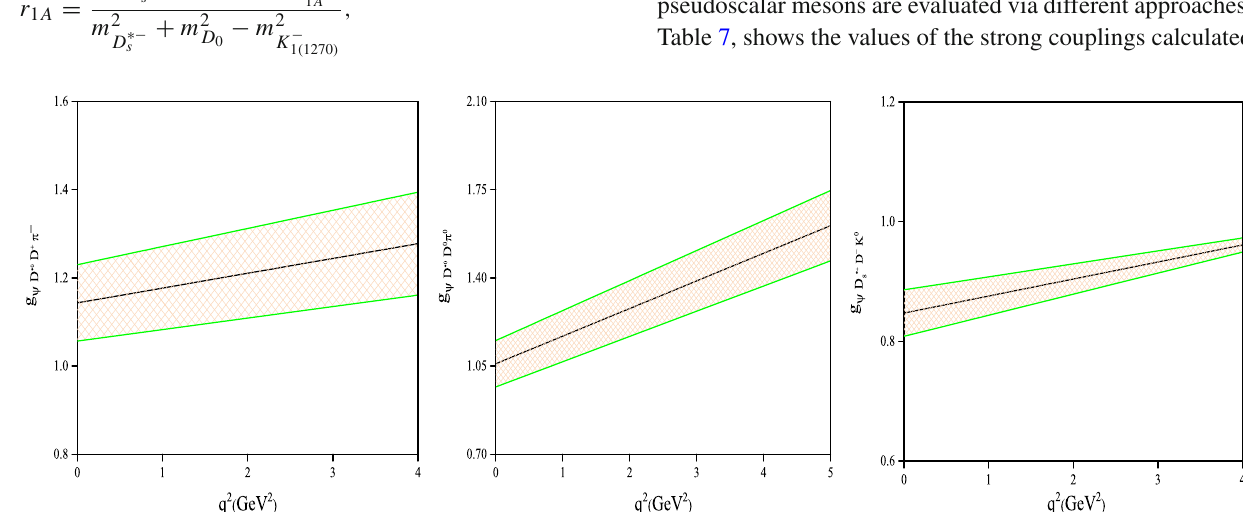
Fig. 5 The strong couplings of (ψ, D ∗ 0 , D + ,π − ) , (ψ, D ∗ 0 , ¯ D 0 ,π 0 ) and (ψ, D ∗+ s , D − , K 0 ) as well as their uncertainly regions on q 2